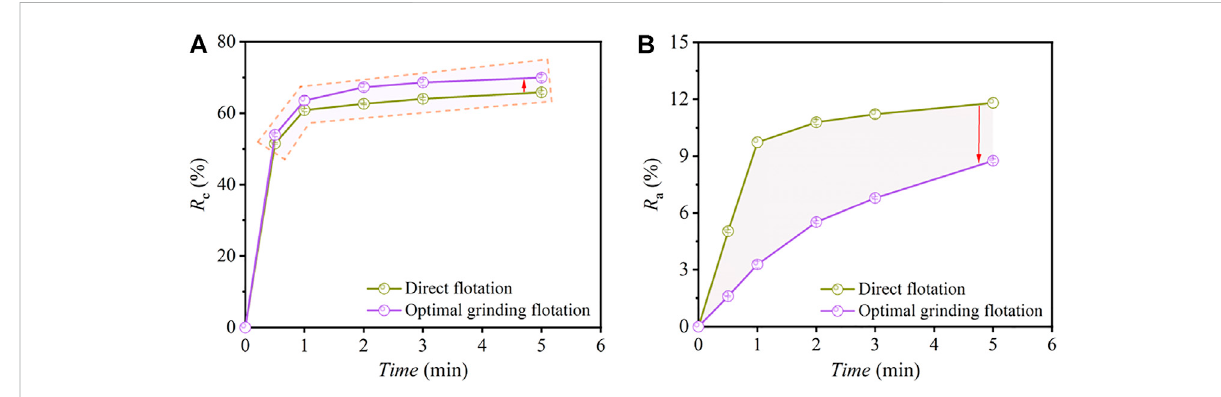
FIGURE 13 R R c (A) and a (B) of concentrate